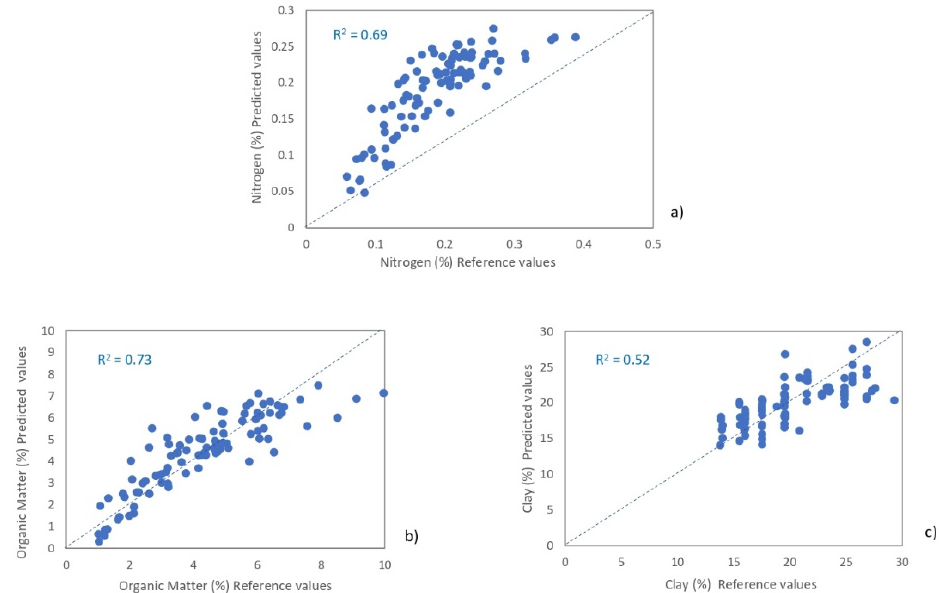
Figure 5. Relationship between predicted and reference values with the best pre-processing trans- formation (spectroscopy transformation SP and PLSR methodology) ( a ) Nitrogen, ( b ) Organic matter and ( c ) Clay.